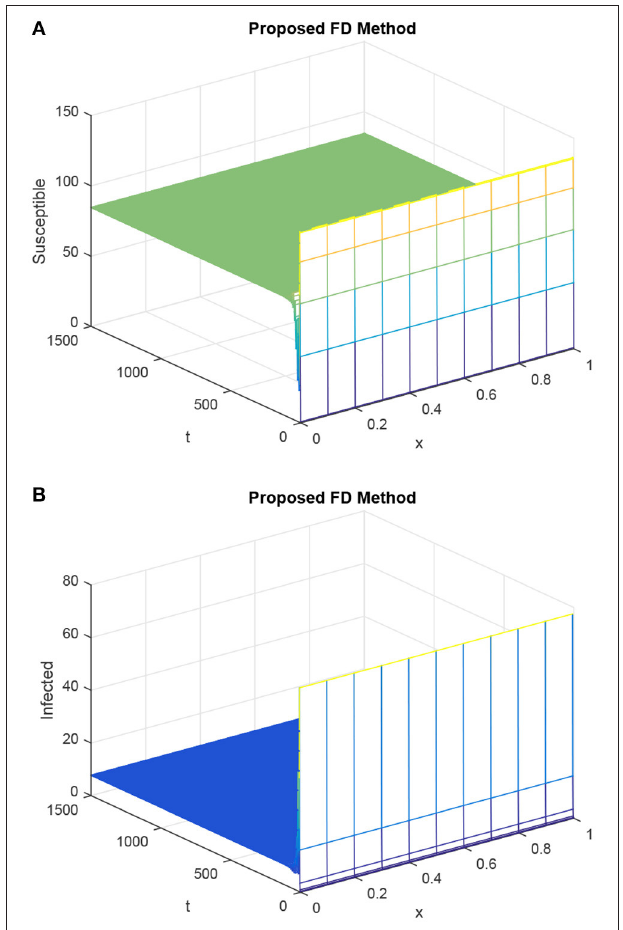
FIGURE 5 | Dynamics of susceptible population and infected population considering h as 0.1 and R 1 = R 2 = 0.15, τ = 6. (A) Mesh graph of S . (B) Mesh graph of I .